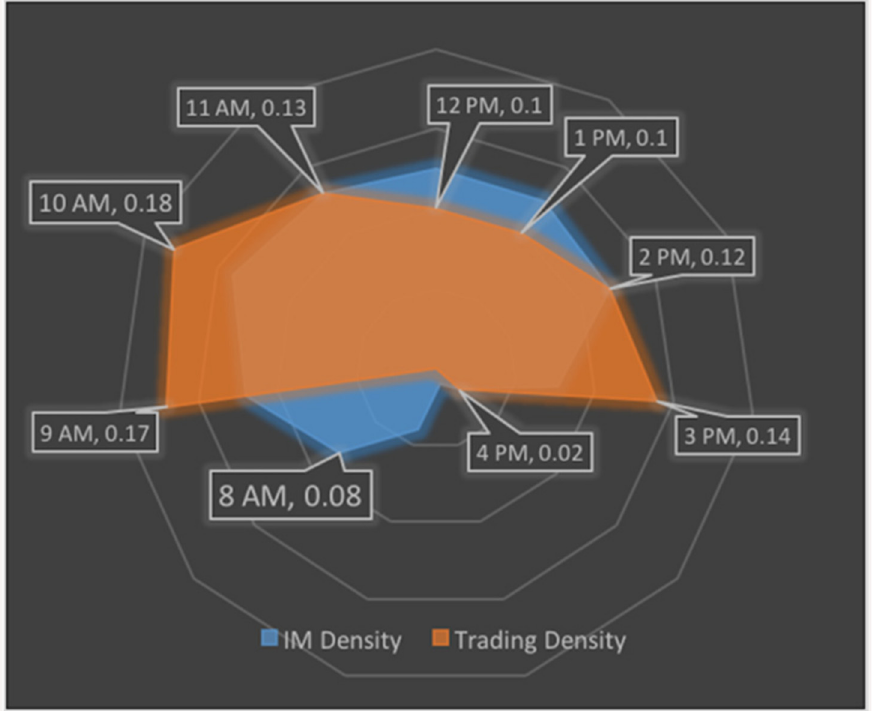
over time and traders in our sample and indicates that changes in the frequency of instant messaging are associated with changes in the frequency of trading. Trading begins at 9am and ends at 4pm. Instant messaging done at any time day or night is captured by the firm ’ s recording